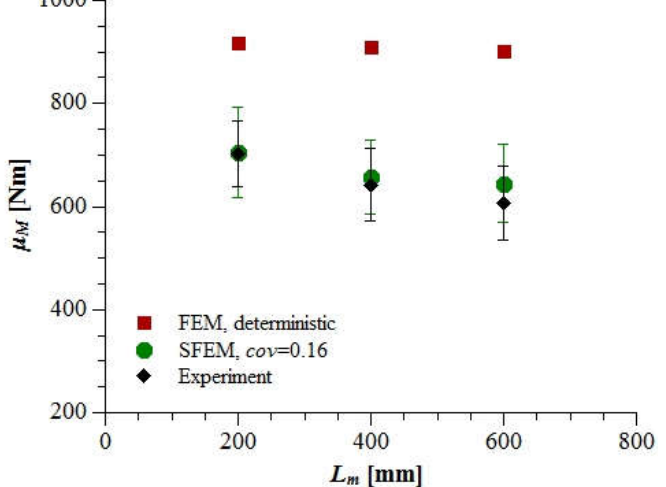
Figure 9. The mean ultimate bending moment ( ± standard deviation) of a beam with increasing span calculated based on SFEM simulations with cov = 0.16 compared with deterministic FEM analysis and the experimental results of Koide et al. (Copyright Permission, Proceedings of FRAMCOS-3, 1998 and Proceedings of ICASP-8, 2000) [7,8].